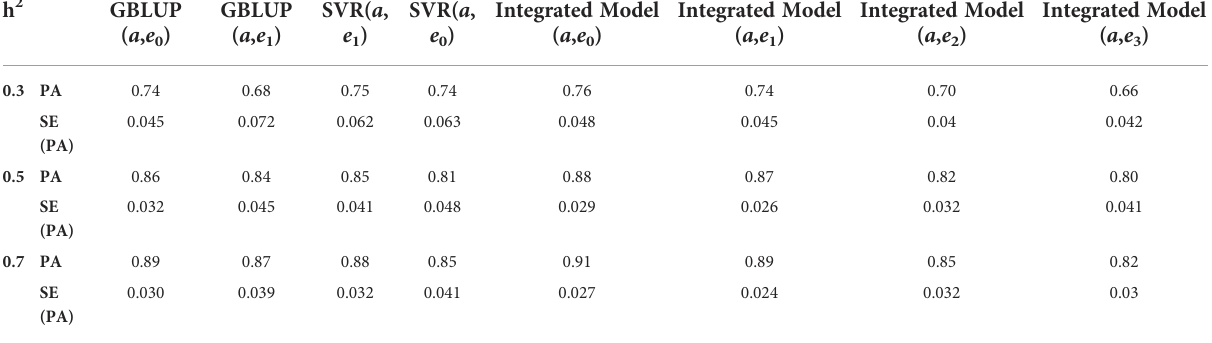
TABLE 6 Predictive ability (PA) with its standard error (SE) for different GS models at different heritability using k-RCV variance.